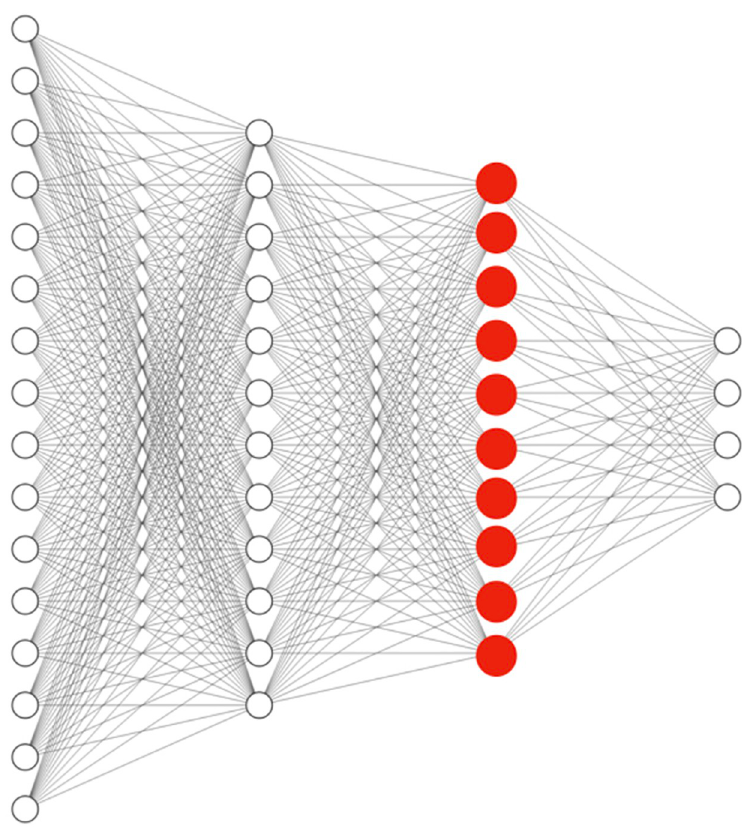
Fig 11. Simple classification network architecture. New representation from the classification task to feed into the pipeline is created by passing through the trained network and picking the red layer.